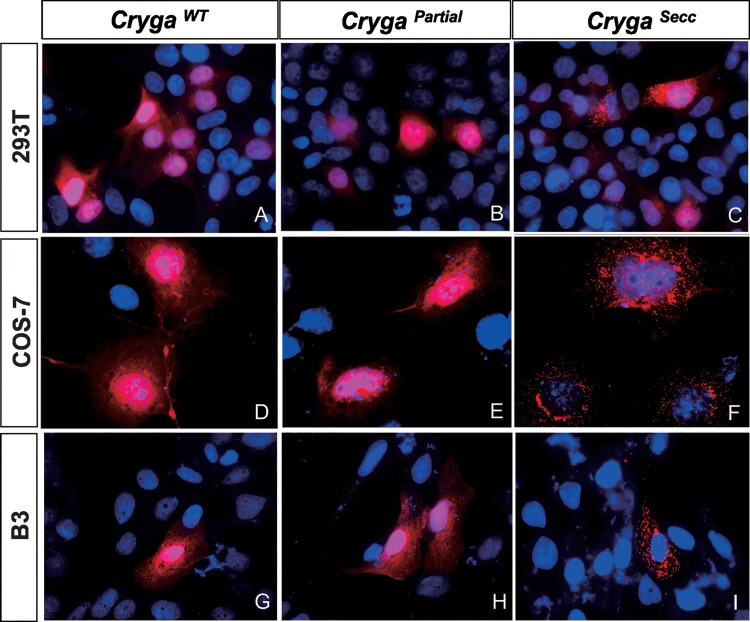
Localization of myc-tagged wildtype, Secc and partial γA-crystallin in 293T, COS-7 and B3 cells.Immunofluorescence of myc-tagged γA-crystallins (red) showing the distribution of wildtype CrygaWT (A, D, G) and CrygaPartial (B, E, H) γA-crystallins in both nucleus and cytoplasm of the transfected cells. Punctate distribution of the CrygaSecc mutant protein (C, F, I) was readily observed in the transfected cells, suggesting the formation of mutant protein aggregates.